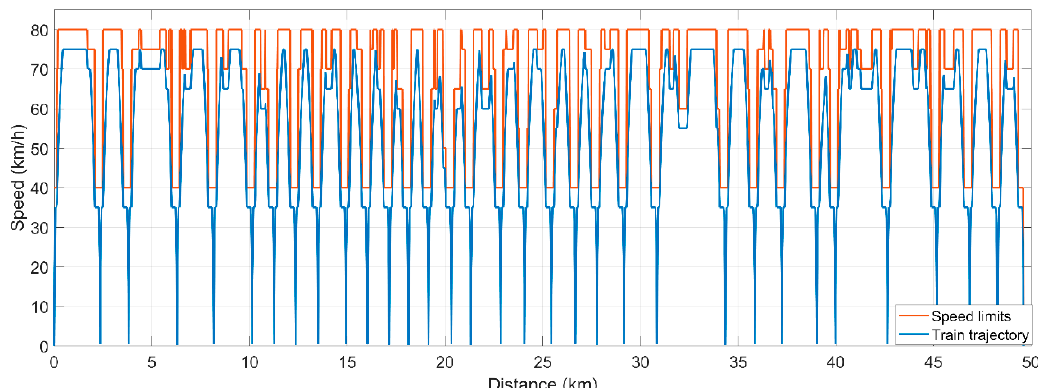
Figure 10. Train operation (down-direction with the station speed limit at 40 km/h).